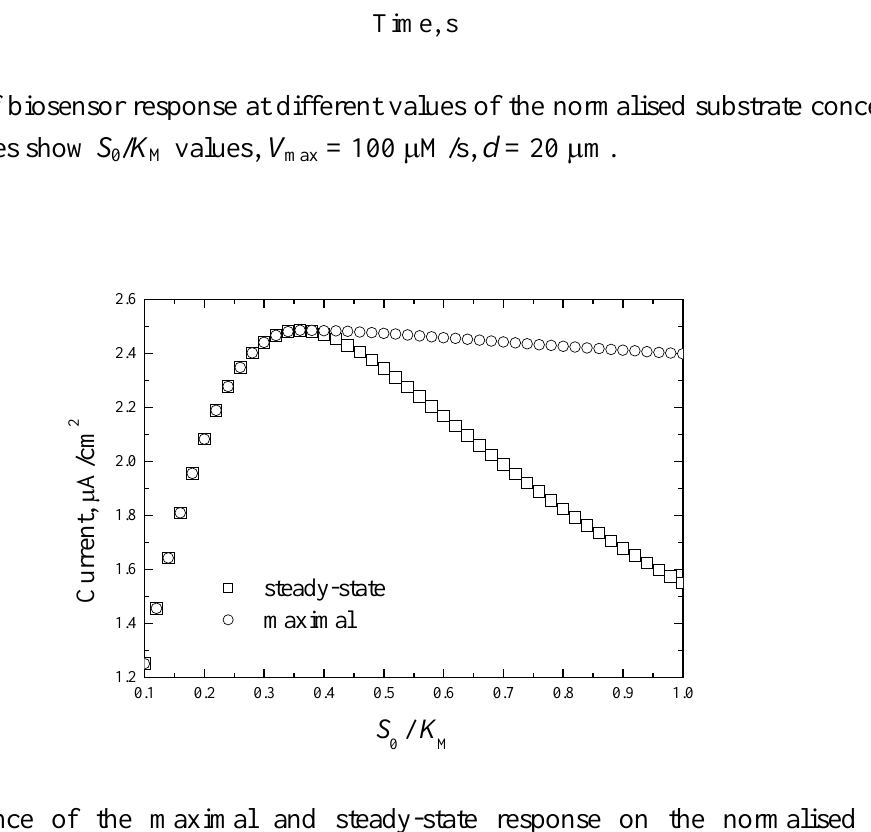
Figure 2 . Dependence of the maximal and steady-state response on the normalised substrate concentration. Calculation parameters as in Fig.